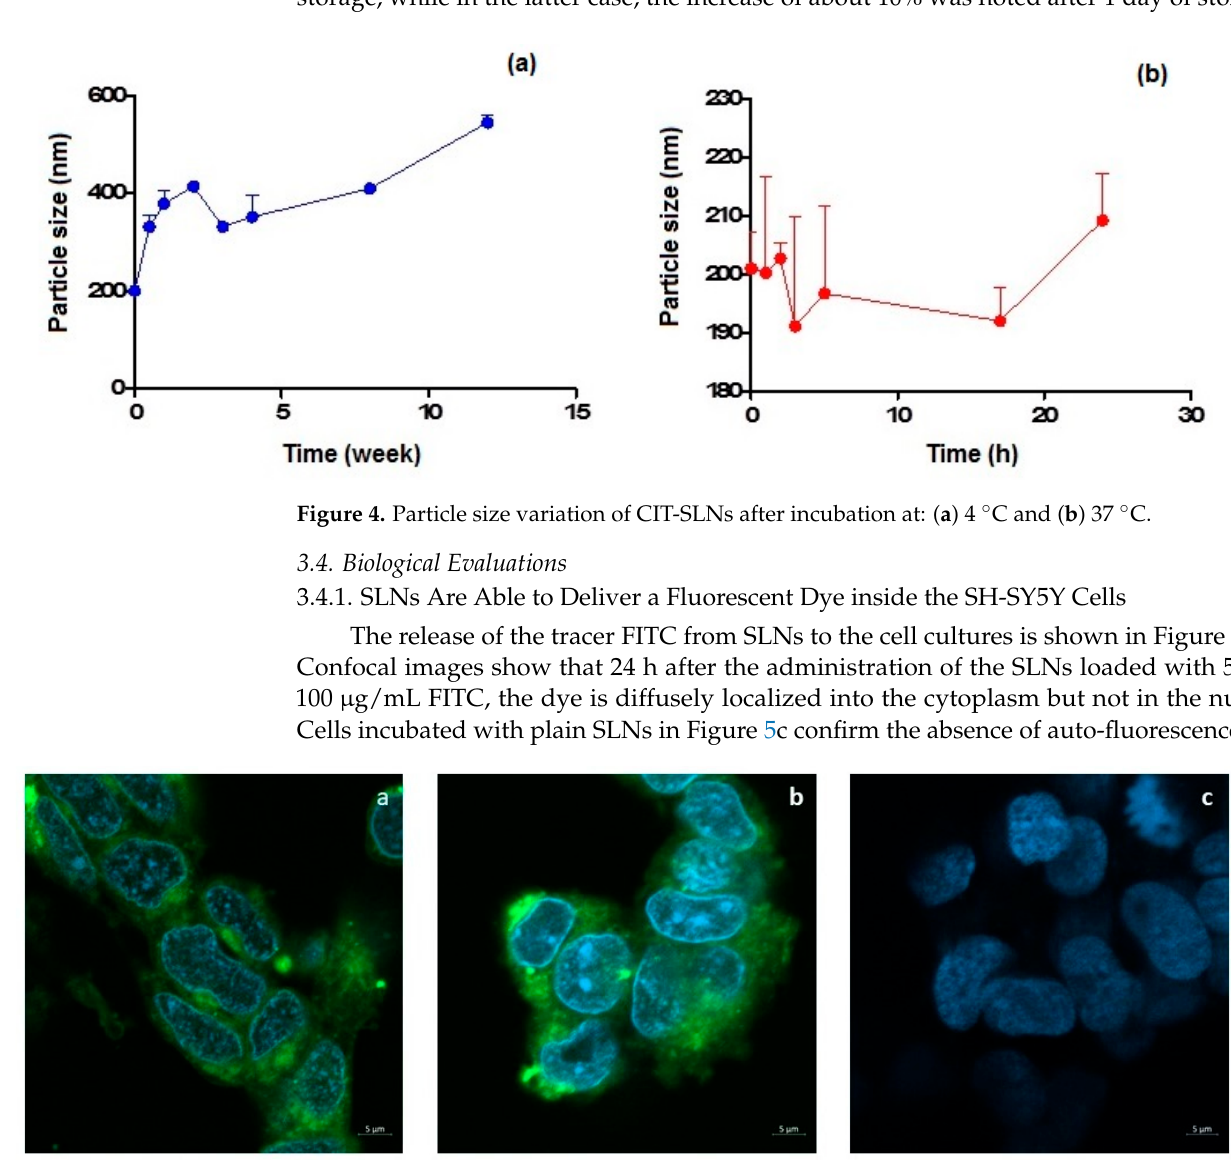
Figure 5. Uptake assay of FITC-loaded SLNs. Confocal microscopy imaging shows that FITC molecules encapsulated into SLNs penetrate the cytoplasm of SH-SY5Ycell cultures. ( a ) FITC-loaded SLNs (50 µg/mL); ( b ) FITC-loaded SLNs (100 µg/mL); ( c ) Plain SLNs (50 µM).